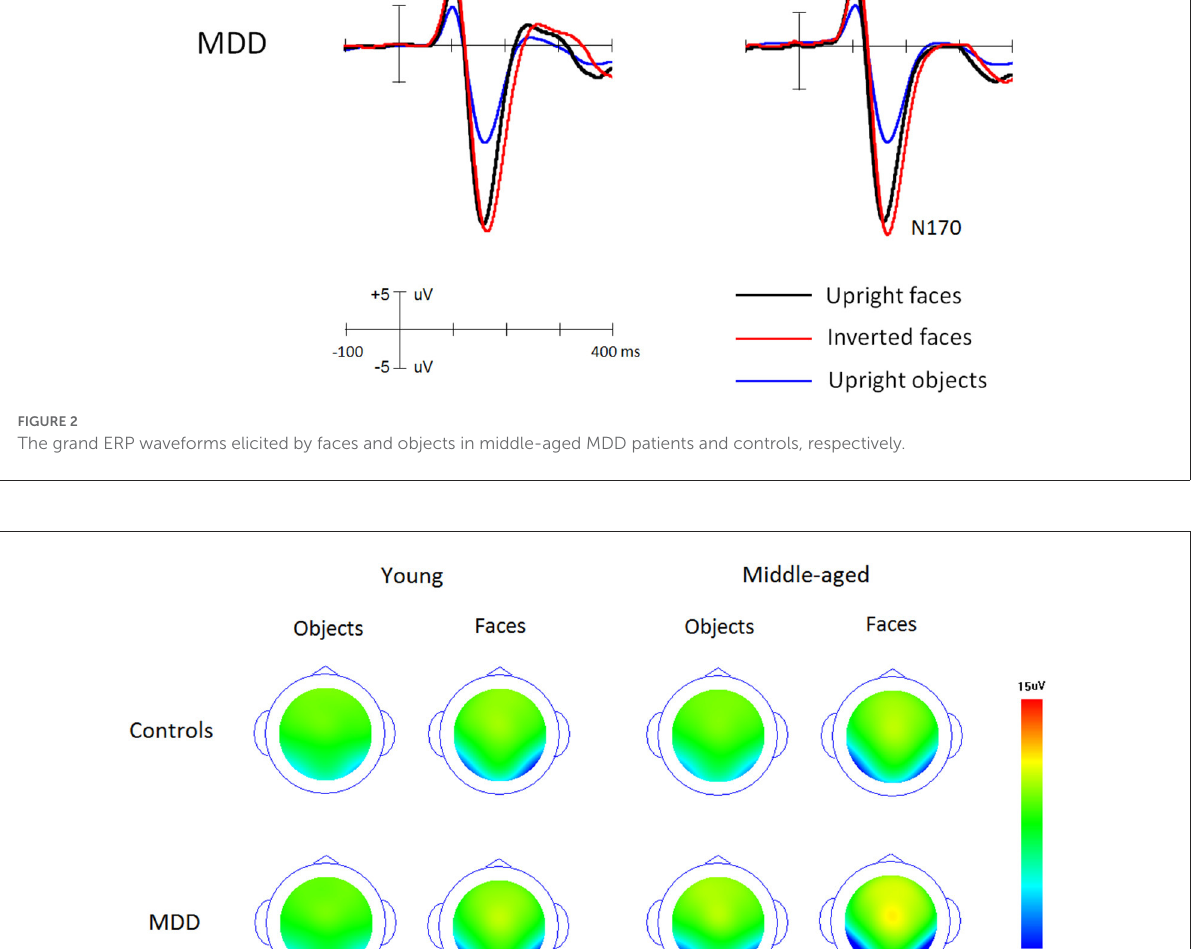
conditions. The two-way interaction of Stimulus ∗ Orientation was significant, F (1,111) = 235.4, p < 0.001, partial η 2 = 0.68, showing N170 inversion effect for faces ( − 2.1 uV, p < 0.001) but not for objects ( − 0.5 uV, p > 0.1).